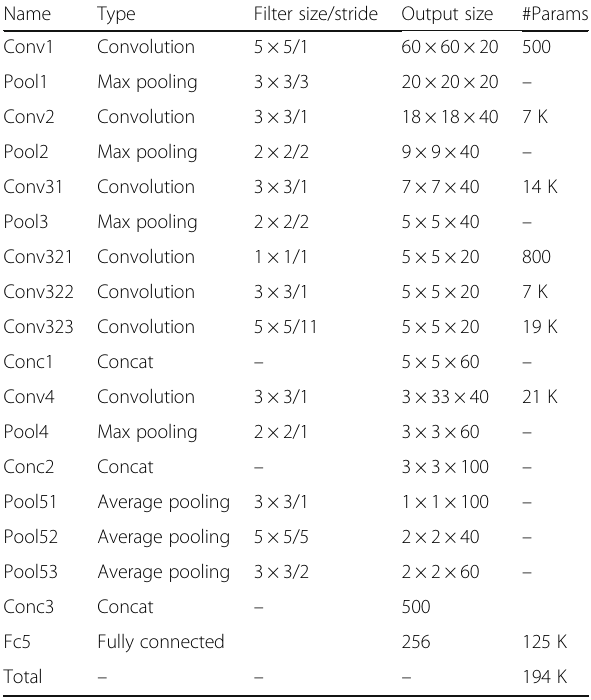
Table 1 The specific configuration of the